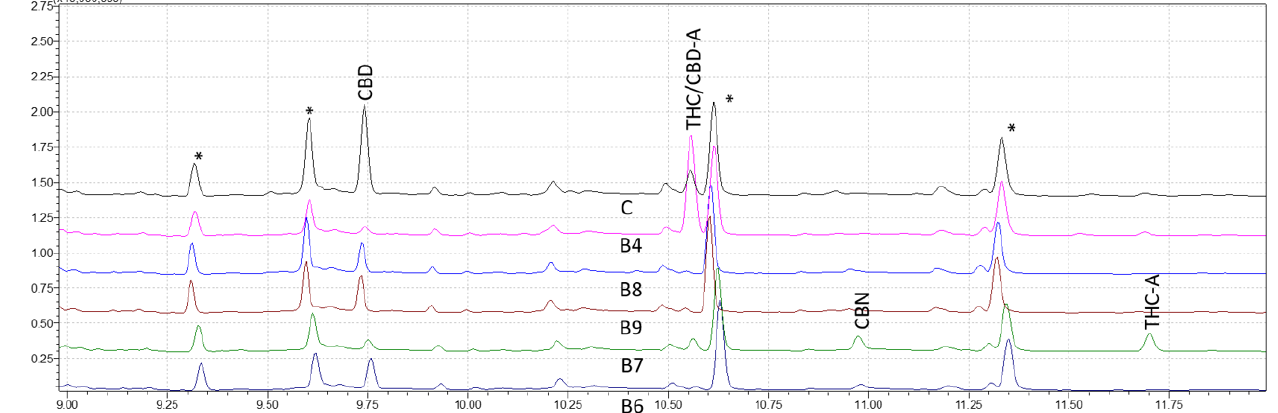
Figure 4. Chromatograms of five derivatized forensic samples analyzed through fast retention window (FRW) method of gas chromatography-mass spectrometry (GC–MS). Asterisks (*) represent trimethylsilyl esters (TMS) derivatives.